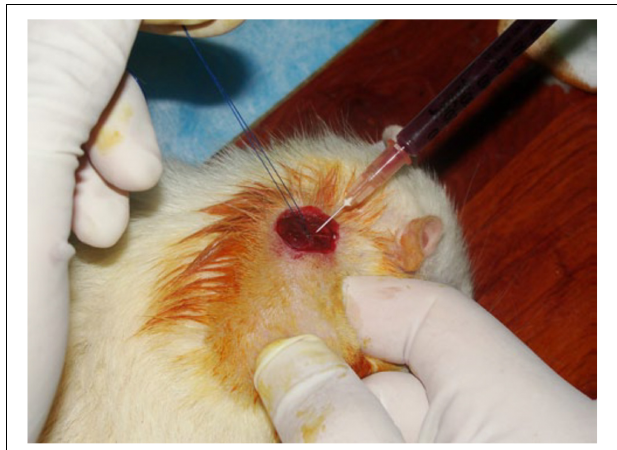
FIGURE 6 | Injecting platelet-rich plasma into the repair site (Ersen et al.,